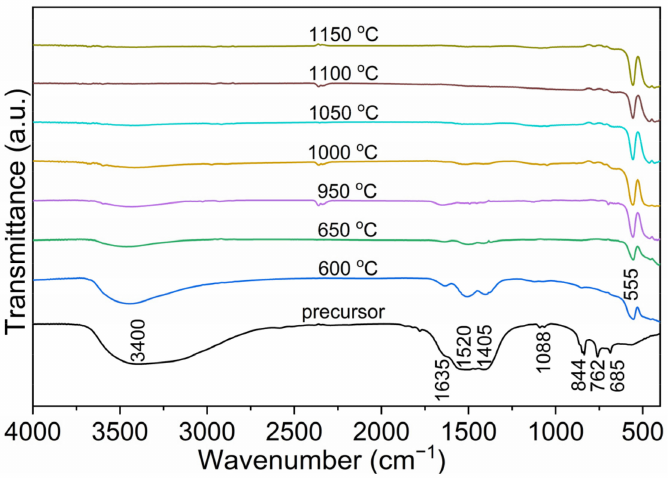
Figure 4. FTIR spectra of the Dy 2 O 3 precursor and the powders calcined at 600, 650, and 950–1150 ◦ C. The XRD patterns of the Dy 2 O 3 powders calcined at 600, 650, and 950–1150 ◦ C